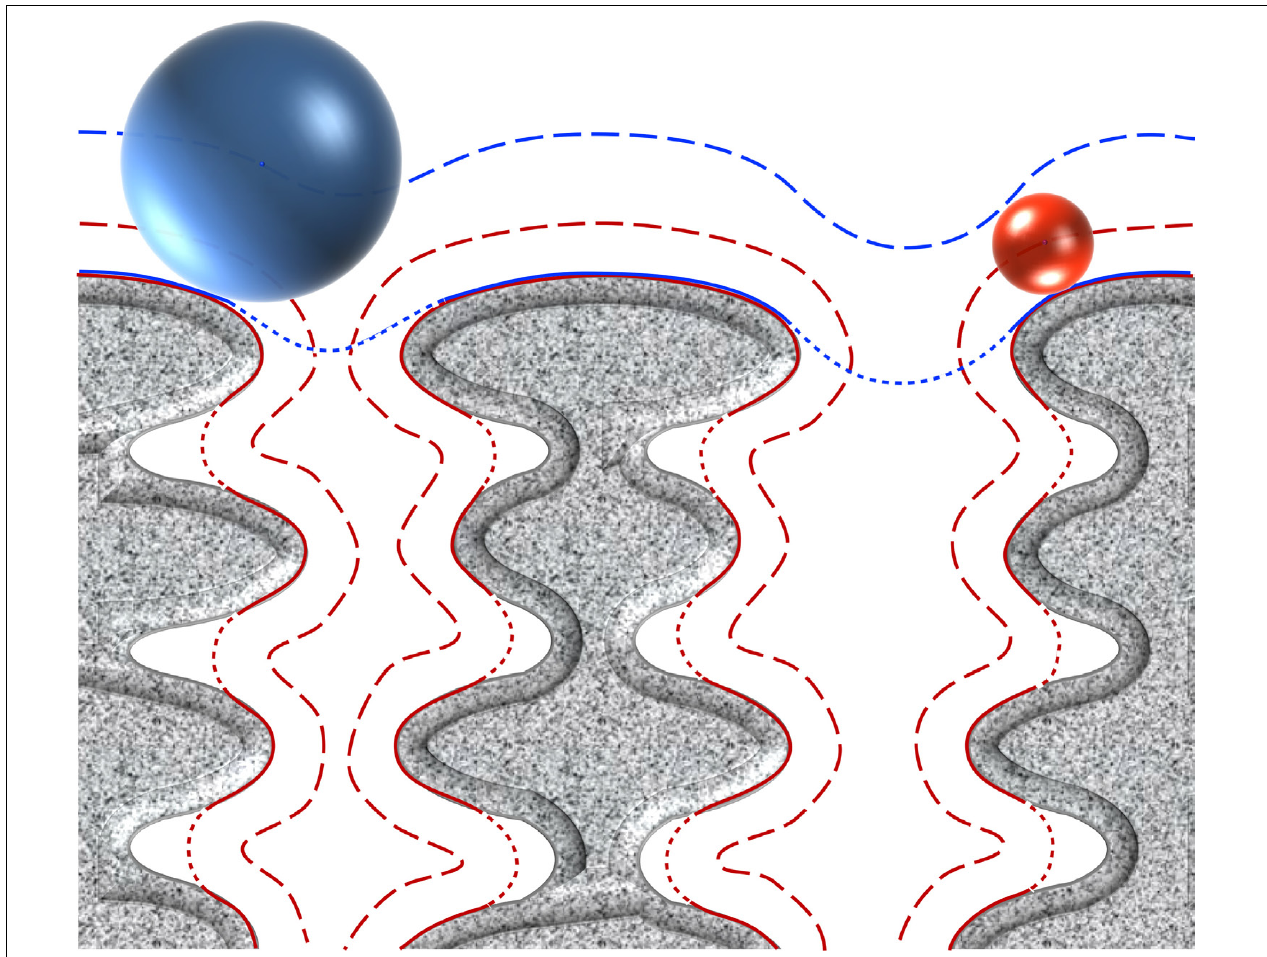
FIGURE 2 | Concepts of molecular surface, contact surface, accessible surface, and reentrant surface to define the bacterial cell surface in parietal monoderm bacteria. Taking molecules of different sizes, their penetration in the cell envelope differs. The blue sphere represents a molecule of high molecular weight unable to penetrate the CW fabric (depicted in grey), whereas the red sphere represents a smaller molecule diffusing through. Depending on the molecules considered, the definition of the bacterial cell surface will also differ. The continuous lines represent the contact surface that is the molecular surface that actually comes in direct contact with the surface of the molecule considered. The dashed lines represent the accessible surface that is the continuous sheet referring to the centre of the molecule considered. The dotted lines correspond to the reentrant surface that is the interior-facing part of the molecule considered when it cannot come in direct contact with the molecular surface of the cell envelope. The definition of bacterial cell surface of parietal monoderm bacteria is thus very different when referring to the molecular surface of the cell envelope or the contact, accessible and reentrant surfaces with respect of the size of the molecule under